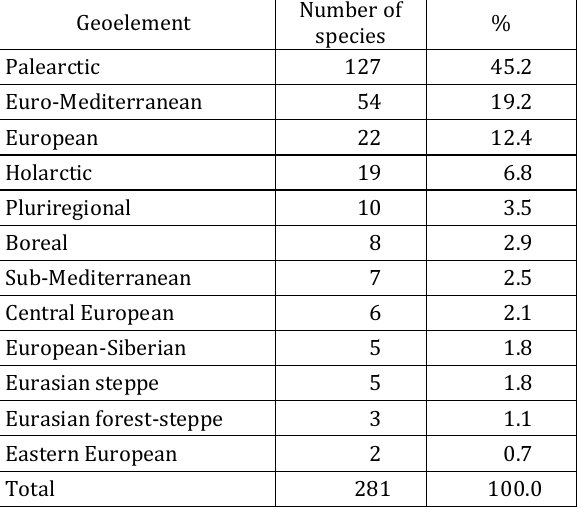
Table 4. Geographical structure of the native fraction of the flora of the Botanical Garden